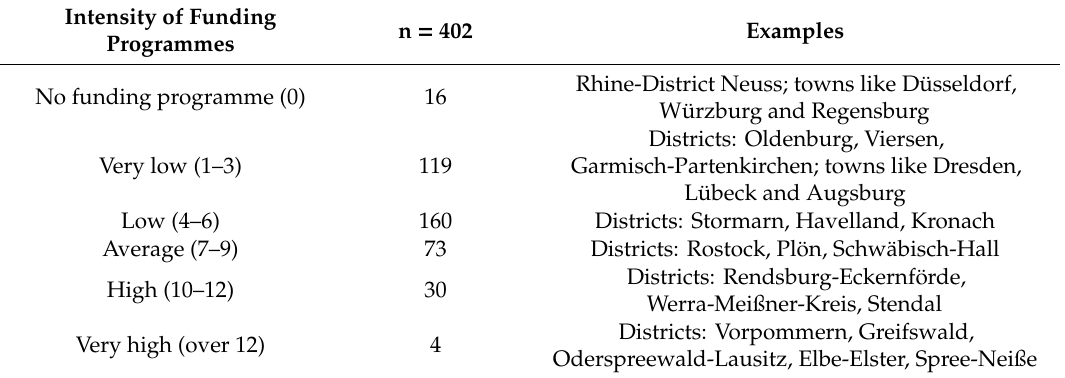
Table 1. Number of programmes in the German districts and towns with district